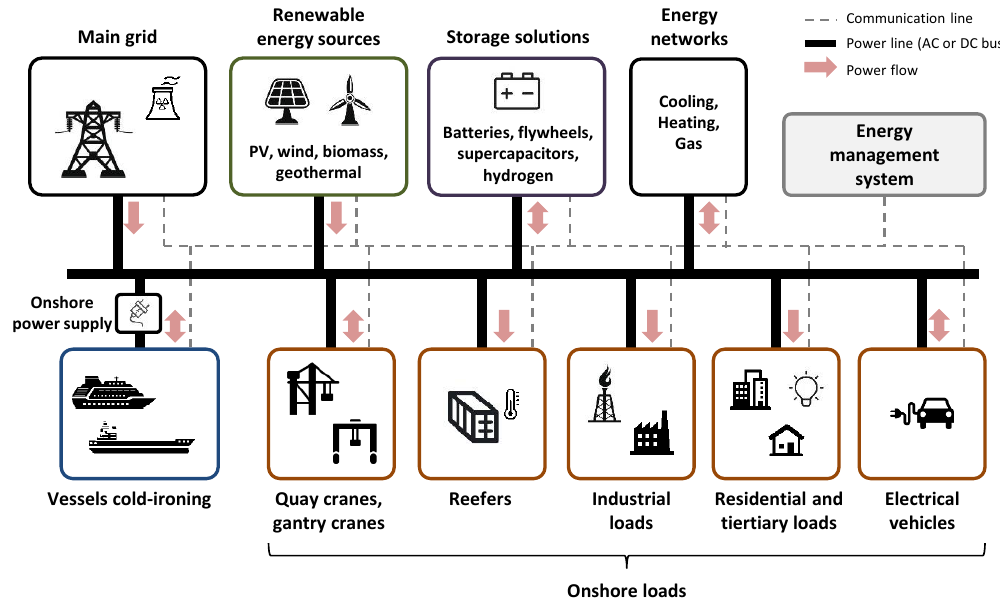
Figure 2. Overview of possible harbor microgrid facilities.